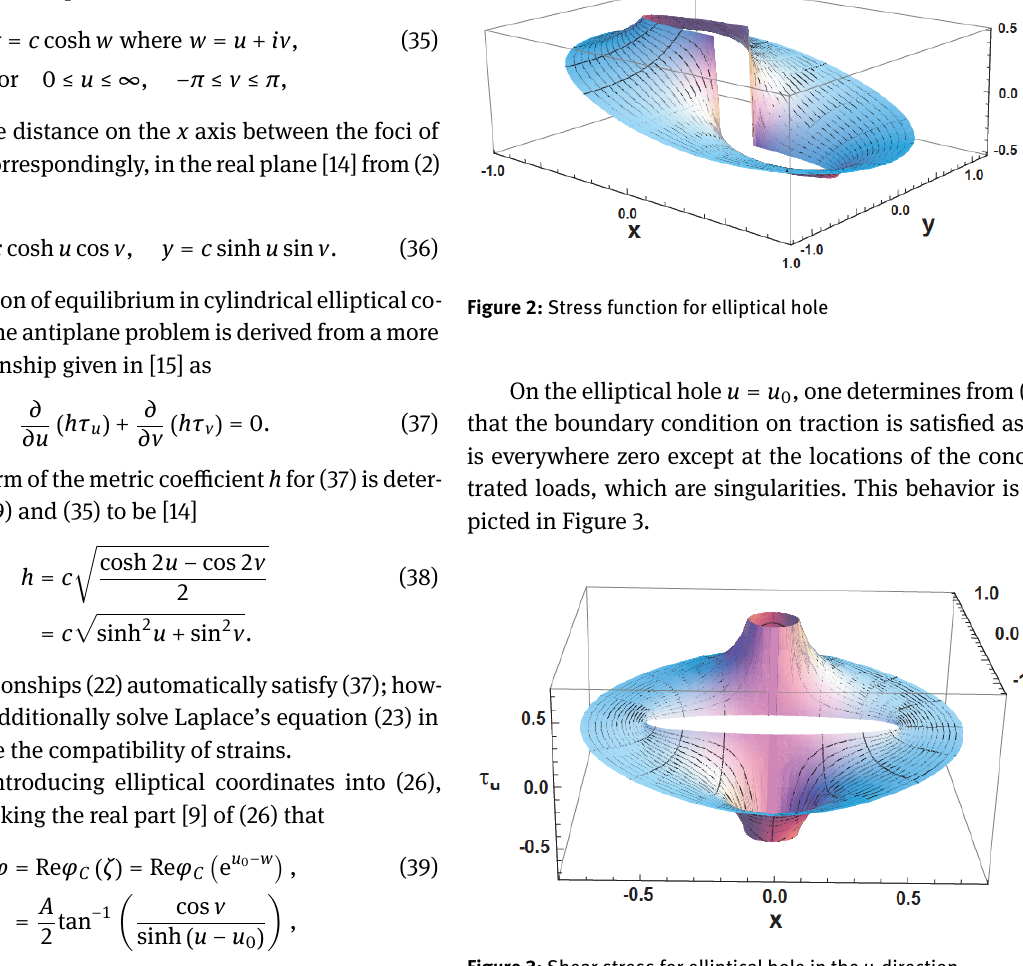
Figure 3: Shear stress for elliptical hole in the u-direction